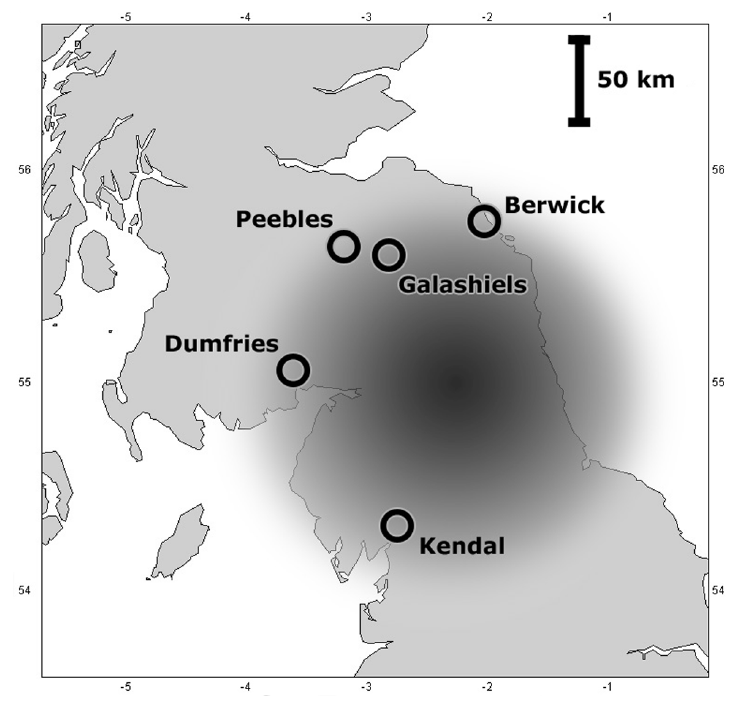
Fig. 6. Conjectured felt area for the lost June 1668